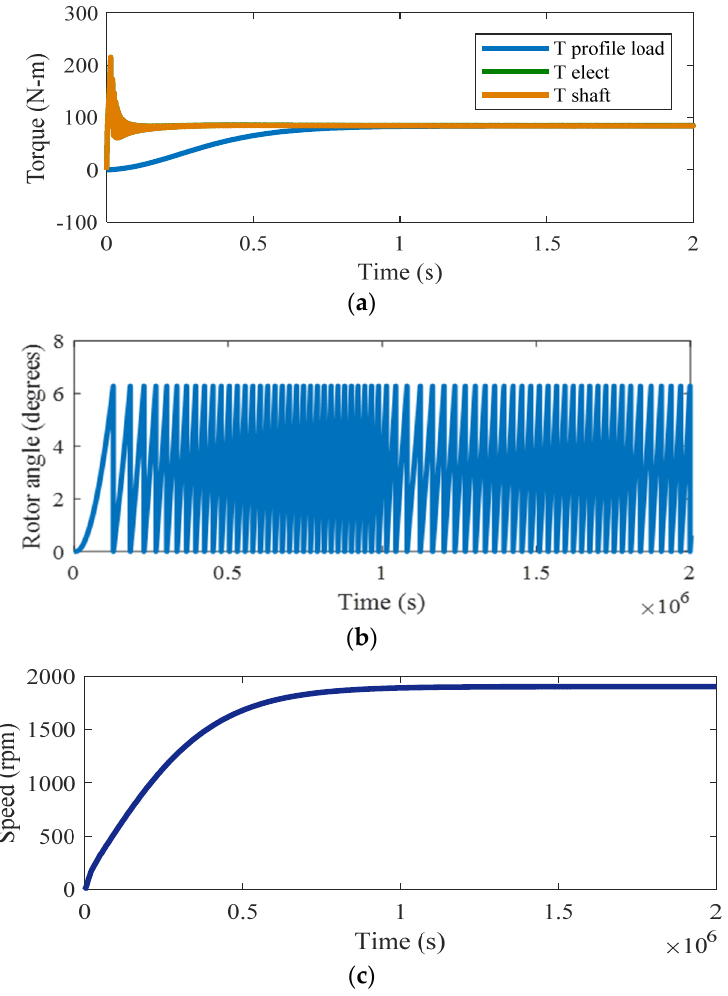
Figure 14. The variations in Te, Rotor angle and speed: ( a ) Electromagnetic torque vs Time ( b ) Rotor angle vs Time and ( c ) Speed Vs Time.